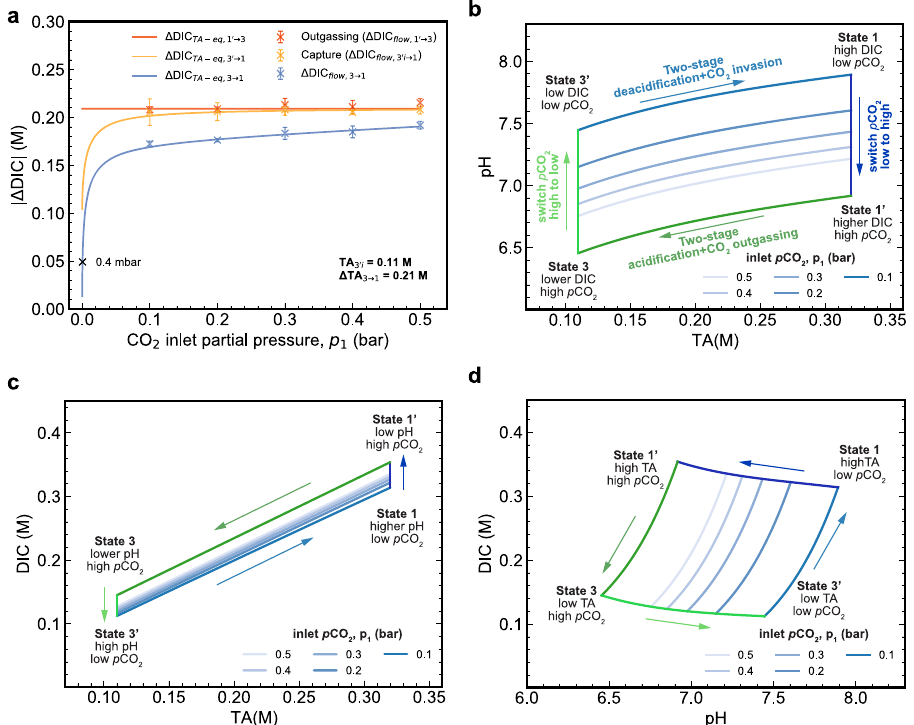
Fig. 4 Summary of the experimental concentrating cycles with different inlet p CO2 in Fig. 3 and the TA (total alkalinity)/pH/DIC (dissolved inorganic carbon) relations of the ideal cycles with corresponding experimental conditions. a Δ DIC fl ow extracted from Fig. 3e, f (colored “ x ” markers) and calculated Δ DIC TA − eq given TA 3 ′ i = 0.11 M and Δ TA 3 → 1 = 0.21 M (lines). The black “ x ” marker refers to the result that Δ DIC for the ideal cycle equals 0.049 M when p CO 2 = 0.4 mbar. The error bars refer to the standard deviation. b pH vs . TA in the ideal cycles, assuming TA 3 ′ i = 0.11 M, Δ TA 3 → 1 = 0.21 M and gas-solution equilibrium. p 1 in the legends represents p CO 2 during the two-stage deacidi fi cation + CO 2 invasion process. The arrows indicate the direction of the processes in the experiments. c DIC vs . TA in the ideal cycles. d DIC vs . pH in the ideal